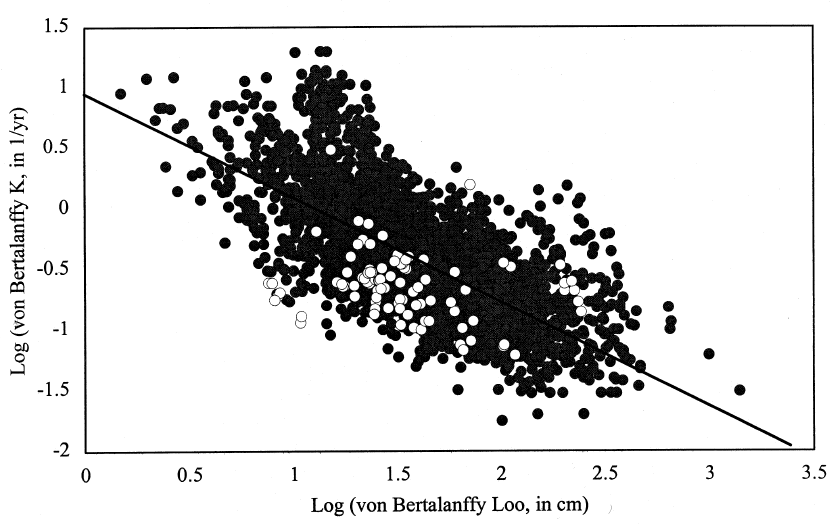
Fig. 4. Relationship be- tween the von Bertalanffy parameters for K and L oo a variety of fish stocks in Hellenic waters (open circles) and for 4830 stocks registered in Fish- Base 98 (black circles; data from the Pop- Growth table: Binohlan and Pauly 1998). The two slopes differ signifi- cantly (ANCOVA,